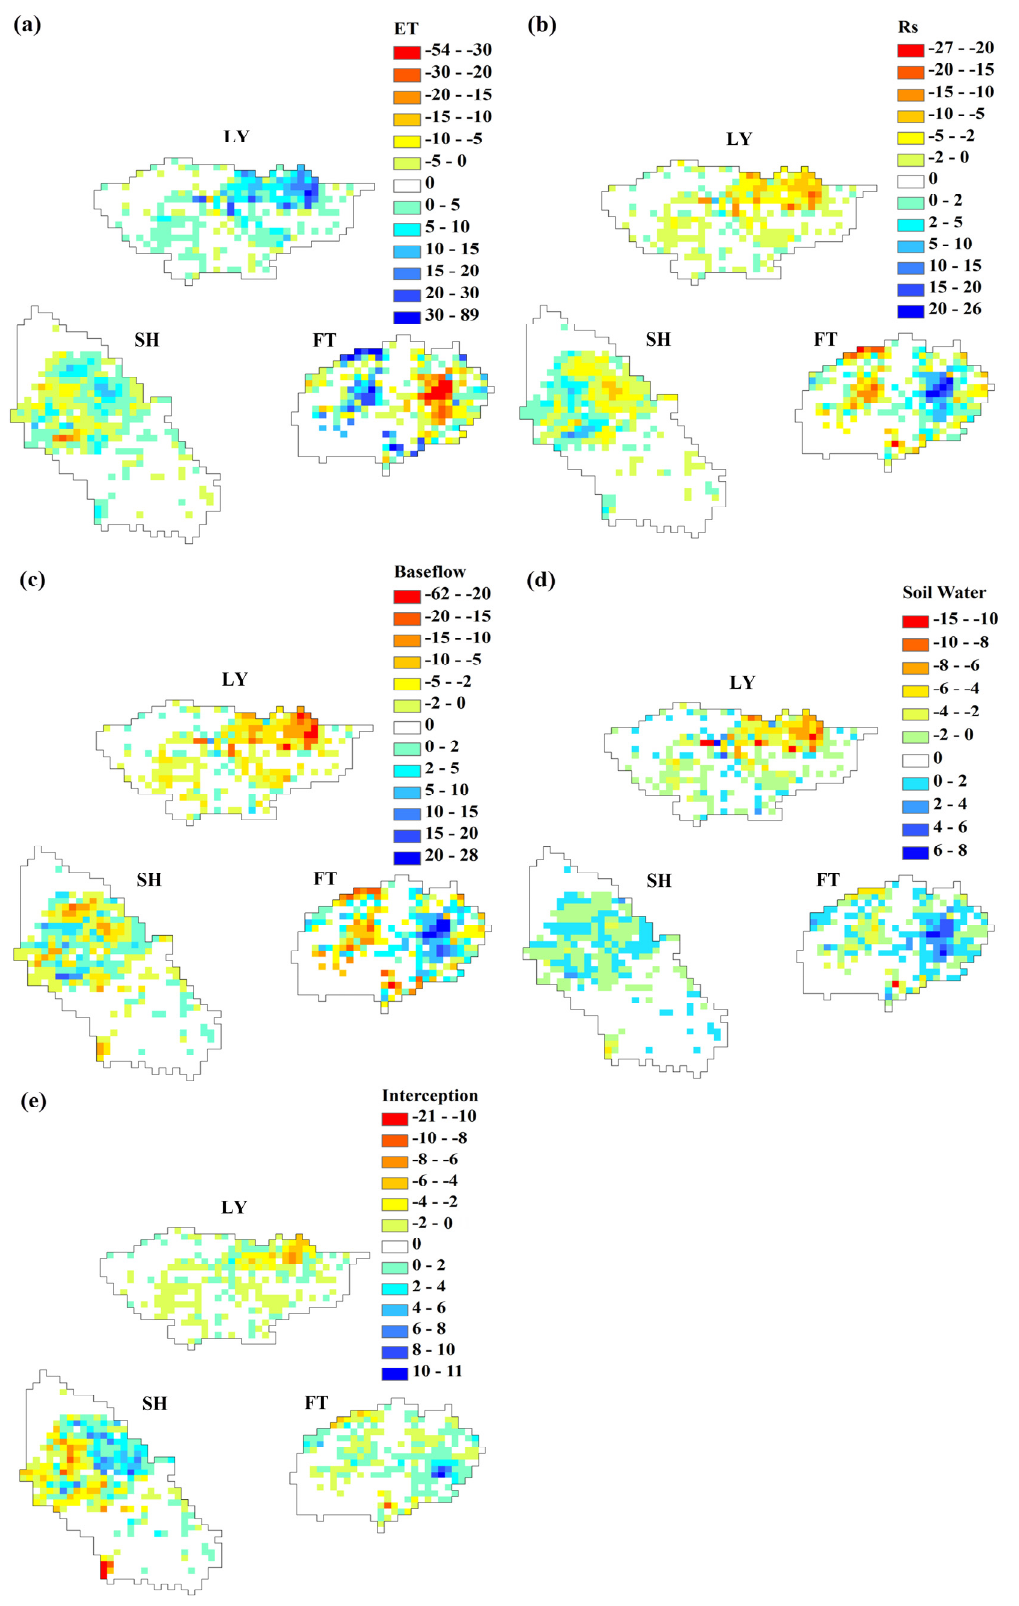
Figure 5. Differences in the hydrological elements in Scenario S2-S1: ( a ) change in evapotranspiration; ( b ) change in surface water generation; ( c ) change in baseflow; ( d ) change in soil water; and ( e ) change in canopy